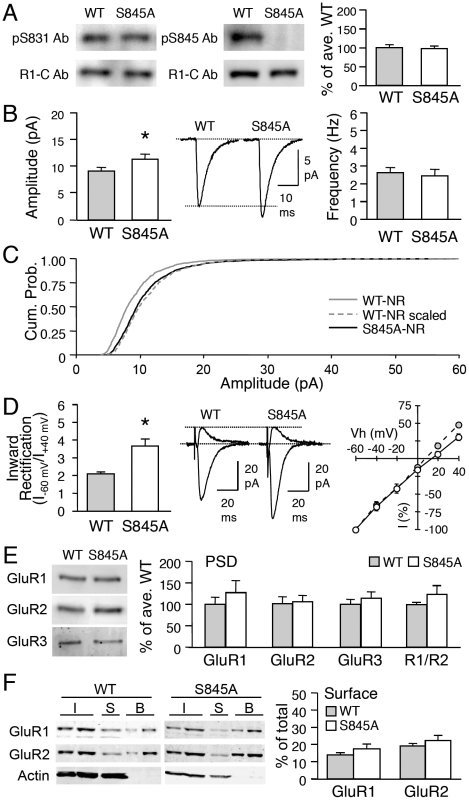
GluR1-S845A mutants have larger mEPSCs and have functional CP-AMPARs under basal conditions.
(A) Immunoblot analysis of visual cortex samples from normal-reared WT and S845A mutants. Left: Sample immunoblot probed simultaneously with phospho-antibody for GluR1-S831 (pS831 Ab) and GluR1 C-terminal antibody (R1-C Ab). Middle: Sample immunoblot simultaneously probed with phospho-antibody for GluR1-S845 (pS845 Ab) and R1-C Ab. Note the absence of pS845 Ab signal in S845A sample. Right: Quantification of relative phosphorylation at GluR1-S831 in WT and S845A mutants. (B) Left: Significantly larger average basal mEPSC amplitude in GluR1-S845A mutants (*: t-test, p<0.05). Middle: Average mEPSC traces from WT and S845A. Right: No change in average mEPSC frequency. (C) GluR1-S845A mutants display larger mEPSC amplitude values under basal conditions (normal-reared) when compared to WTs. This is shown as a rightward shift in the cumulative probability graph of S845A-NR (black solid line) when compared to that of WT-NR (gray solid line). The amplitude of individual mEPSCs recorded from WT-NR was multiplied by a factor (1.2) to allow the average mEPSC amplitude of WT NR to match that of S845A-NR (WT-NR scaled, gray dotted line). The cumulative probability curve of WT-NR scaled (gray dotted line) was statistically significantly different from the S845A-NR curve (black solid line) (p<0.05, Kolmogrov-Smirnov test) suggesting that S845A mutation does not multiplicatively scale up mEPSCs compared to WT. (D) Left: Significantly larger inward rectification index of evoked AMPAR-EPSC from S845A mutants (*: t-test, p<0.01). Middle: Superimposed inward (Vh = –60 mV) and outward (Vh = +40 mV) currents through AMPARs from NR WT and S845A. Right: I-V plot of evoked AMPAR-EPSC. Note: I-V curve of S845A mice is inward rectifying (open circles) compared to WTs (gray circles). (E) No difference in GluR1 (left), GluR2 (2nd from left), GluR3 (3rd from left), and GluR1/GluR2 (R1/R2) ratio (right) in PSDs of WT and GluR1-S845A. Left panel: Example blots. (F) Left: Example immunoblots of steady-state biotinylation on isolated layer 2/3 visual cortex slices from wildtype (WT) and S845A mutant (S845A). Different amount of total sample (I, input: 2.5% and 5% of total input each lane), intracellular fraction (S, supernatant), and surface biotinylated fraction (B: 10% and 20% of total biotinylated sample each lane) were loaded to the gel, and probed for GluR1, GluR2, and actin. Right: Quantification of surface GluR1 and GluR2 expressed as a percentage of total GluR1 and GluR2 from each blot. No significant difference in GluR1 or GluR2 was observed between wildtypes and S845A mutants.